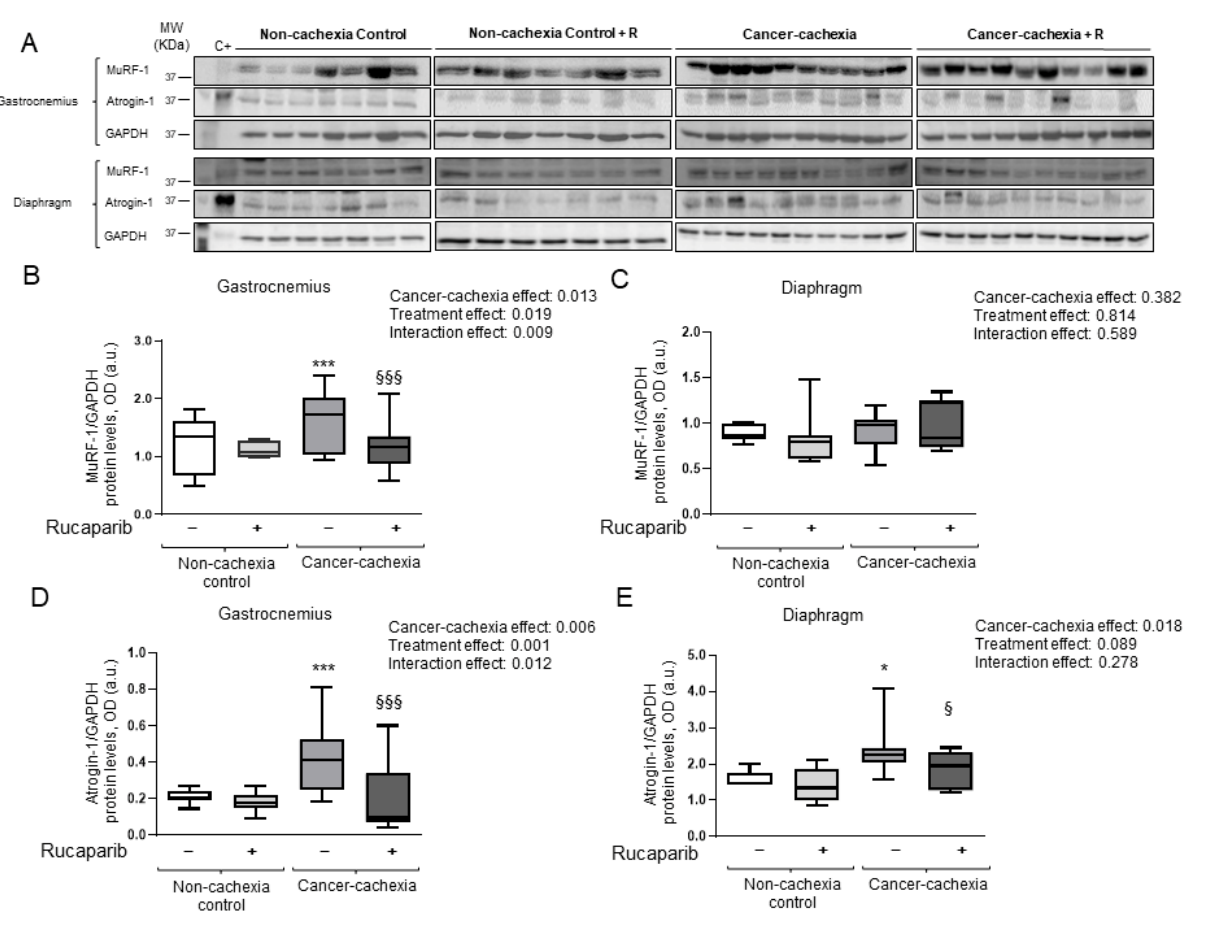
Figure 6. Immunoblots examples of MuRF-1, atrogin-1, and GAPDH proteins in the gastrocnemius and diaphragm muscles of all experimental groups of mice ( A ). Box plot representation of MuRF-1 protein levels in the gastrocnemius ( B ) and diaphragm ( C ) muscles of the different experimental groups of mice. Box plot representation of atrogin-1 protein levels in the gastrocnemius ( D ) and diaphragm ( E ) muscles of the different study groups of mice. Abbreviations: MuRF-1, muscle RING- finger protein-1; GAPDH, glyceraldehyde-3-phosphate dehydrogenase; MW, molecular weight; kDa, kilodalton; OD, optical densities; a.u., arbitrary units; − , untreated with rucaparib; +, treated with rucaparib. Statistical significance: * p ≤ 0.05 and *** p ≤ 0.001 between the untreated non-cachexia controls and the non-treated cancer cachexia mice; § p ≤ 0.05 and §§§ p ≤ 0.001 between the cancer cachexia mice treated with rucaparib and the non-treated cancer cachexia mice. Two-way ANOVA significance ( p value) of cancer cachexia and treatment and interaction effects are also shown for each variable. Uncropped WB images were shown in Figure